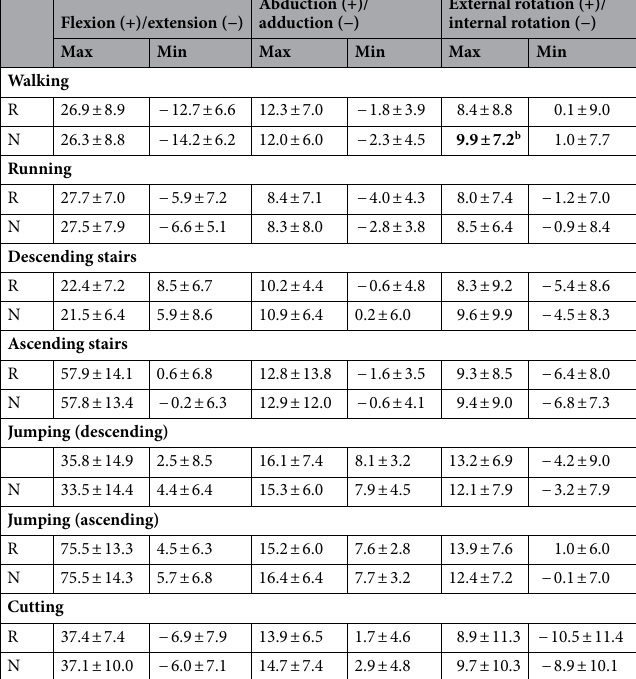
Table 3. Extreme hip joint angles (°) in three motion planes during six functional movements (mean ± standard deviation). N normal shoes, R rocker-soled shoes. a Represents an angle for rocker-soled shoes significantly larger than for normal shoes ( p < 0.007). b Represents an angle for normal shoes significantly larger than for rocker-soled shoes ( p < 0.007). Significant values are in bold.